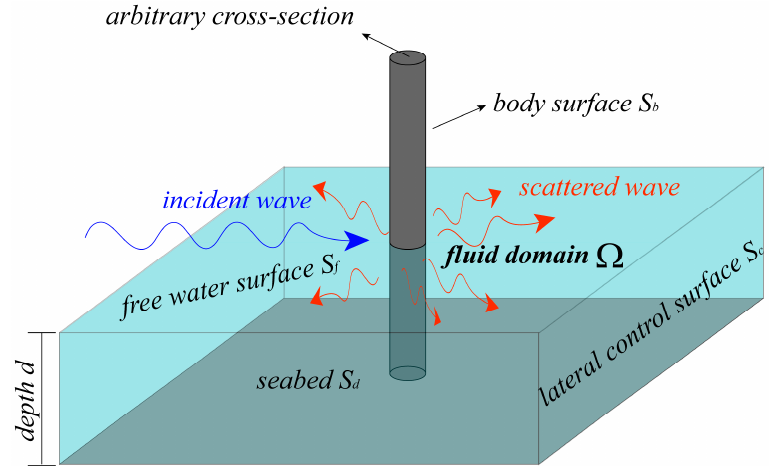
Figure 5. Foundamental problem of wave diffraction.